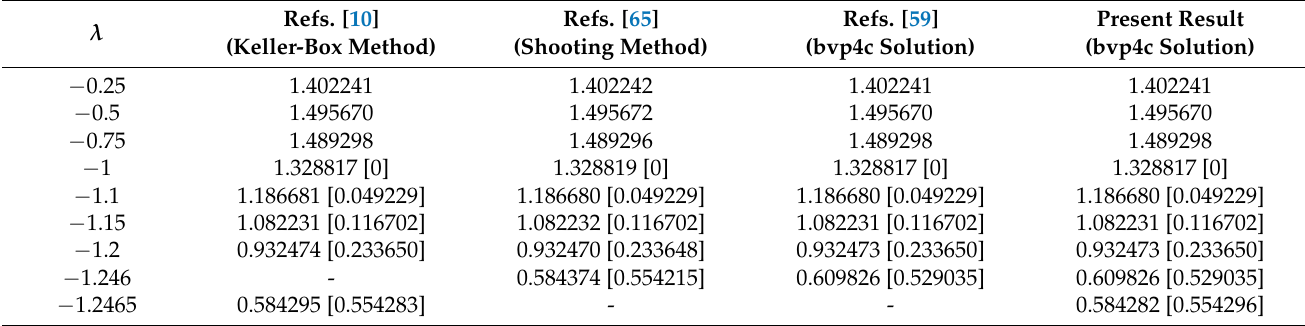
Table 3. Comparison values of f (cid:48)(cid:48) ( 0 ) when A = K = n = 0 and ϕ 1 = ϕ 2 = 0 for different λ